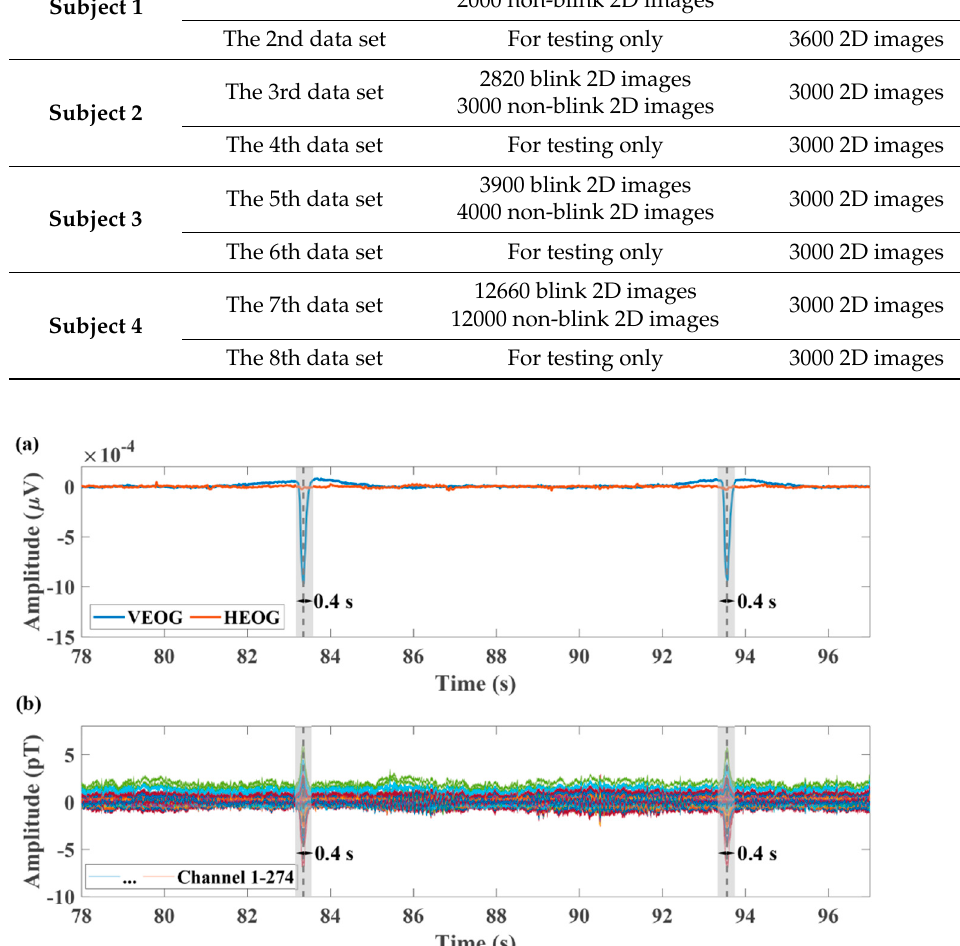
Figure 2. Marking eye movement artifacts. ( a ) A segment of eye movement signals measured by the EOG bipolar. The blue line represents the vertical eye movement signal (VEOG) and the red line represents the horizontal eye movement signal (HEOG). The dotted black line shows where eye movement artifacts appear in the time domain. The blink signals are in the shadow, which last for approximately 0.4 s. ( b ) The marked 274 − channel MEG signals. According to the blink signal, we can mark the time point of the emergence of the blink artifacts in the MEG.